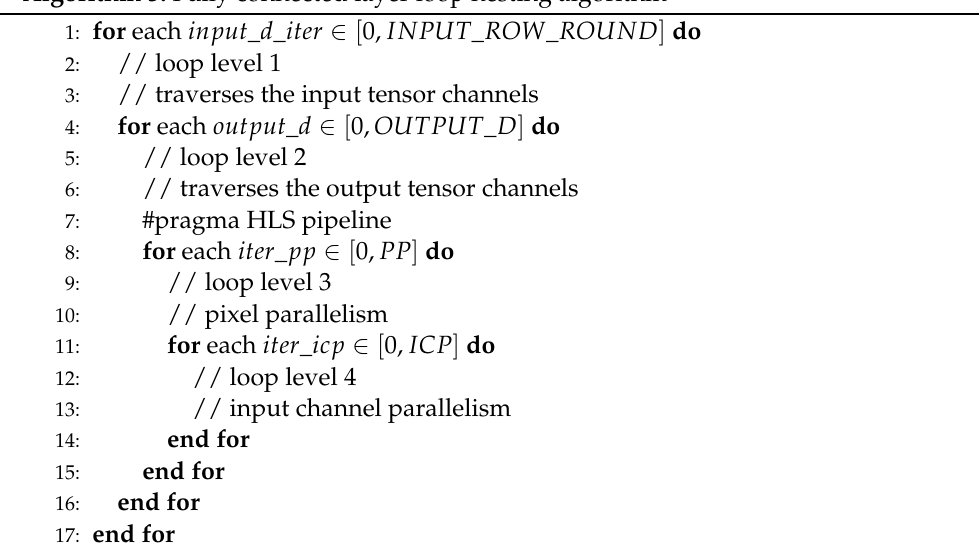
Algorithm 3: Fully connected layer loop nesting